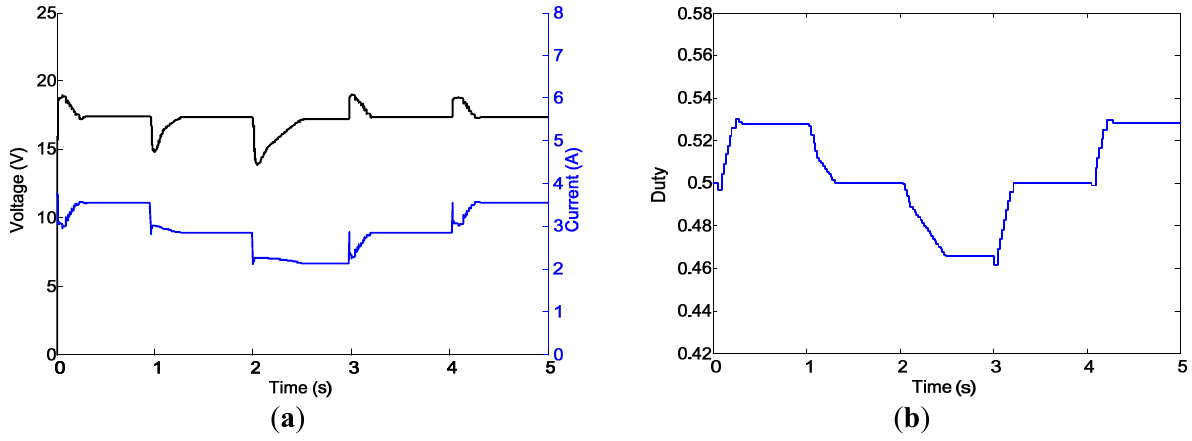
Figure 17. Circuit simulation for irradiation variations using SEPIC converter. ( a ) Voltage and current from PV model; ( b ) Evolution of duty ratio commands.